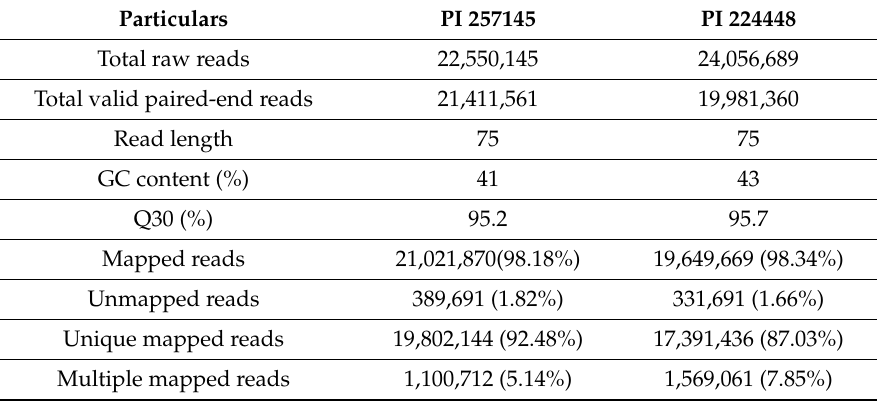
Table 2. Summary of RNA-Seq and reference genome alignment in fruit tissue of Capsicum chinense Jacq.